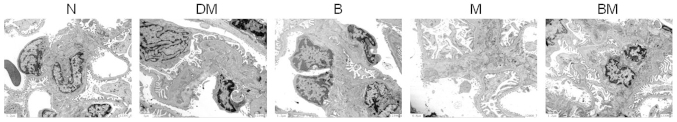
Electron micrographs of the glomeruli of the various groups (magnification, x15,000). N, non-diabetic control; DM, diabetic rats; B, diabetic rats treated with benazepril; M, diabetic rats treated with mycophenolate mofetil; BM, diabetic rats treated with benazepril and mycophenolate mofetil, n=2 per group.